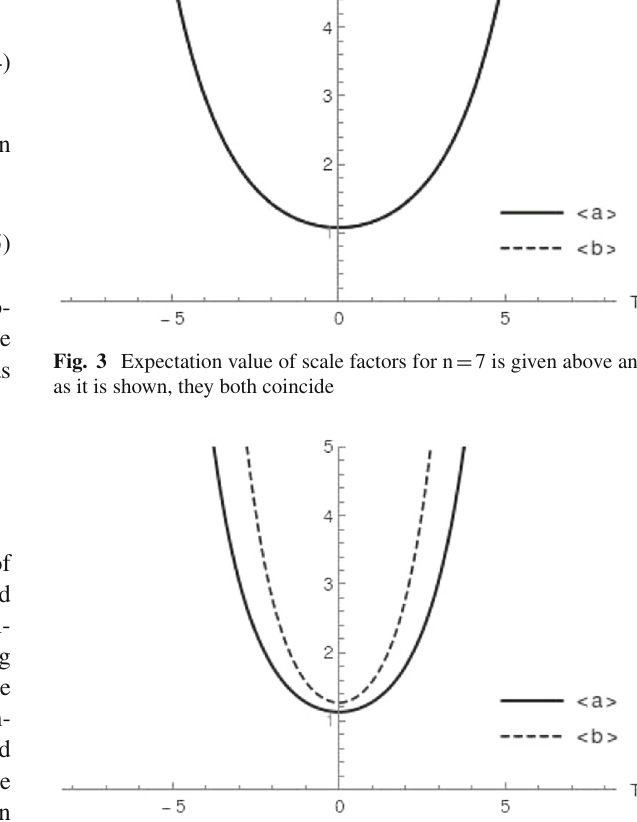
Fig. 4 Expectation value of scale factors for n=5